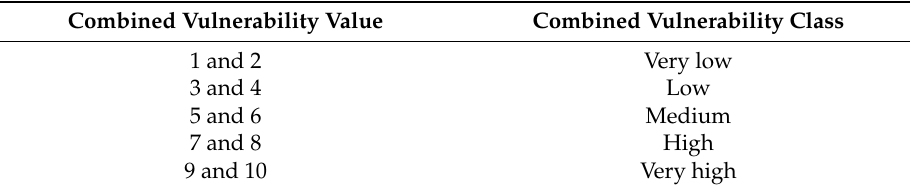
Table 5. Classification of the combined